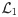
Modulation characteristics of the network.(A,B) Normalized modulation transfer function for layers L1 -left- and L2 -right- displayed in axes of rate (temporal modulations in Hz)—scale (spectral modulations in cycles per octave). (C,D) Overlaid on each transfer function is a contour plot of agglomerative clusters in spectro-temporal modulation space for layers L1 -left- and L2 -right-.(E) Noise ripples are used to analyze the spectro-temporal tuning of the model at different stages. They are noise signals that are modulated in time and frequency. (F) Example filter tuning F(t,f) from layer L1 for 4 nodes exhibiting tuning to harmonicity (top, left), onset (top, right), a slow neuron (bottom, left) and a fast neuron (bottom, right). The filter response profiles have been interpolated using a cubic function for display purposes.